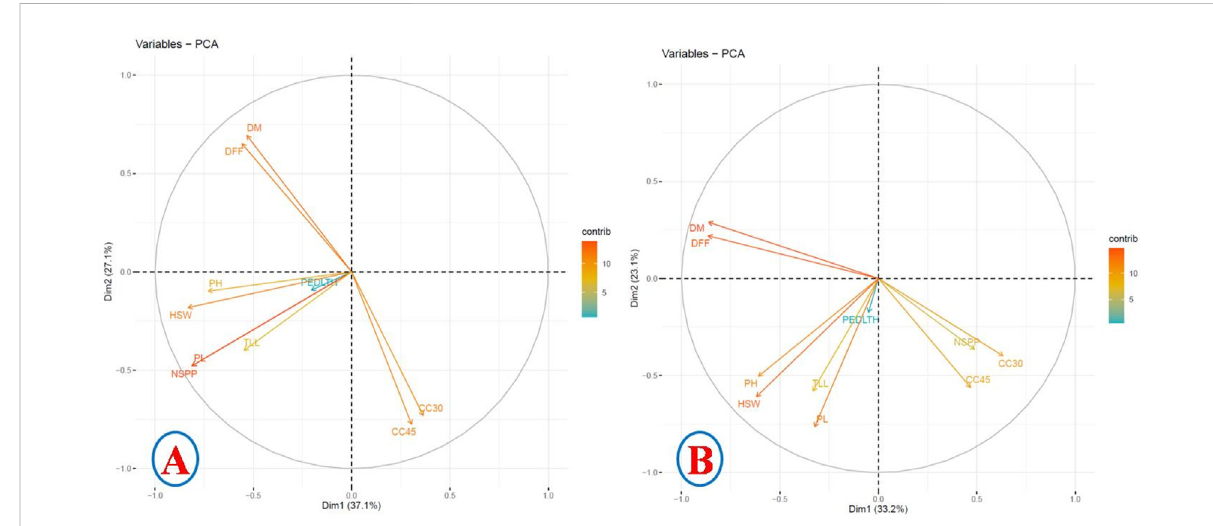
FIGURE 2 Principal component analysis with correlation. (A) 2017 data. (B) 2018 data.